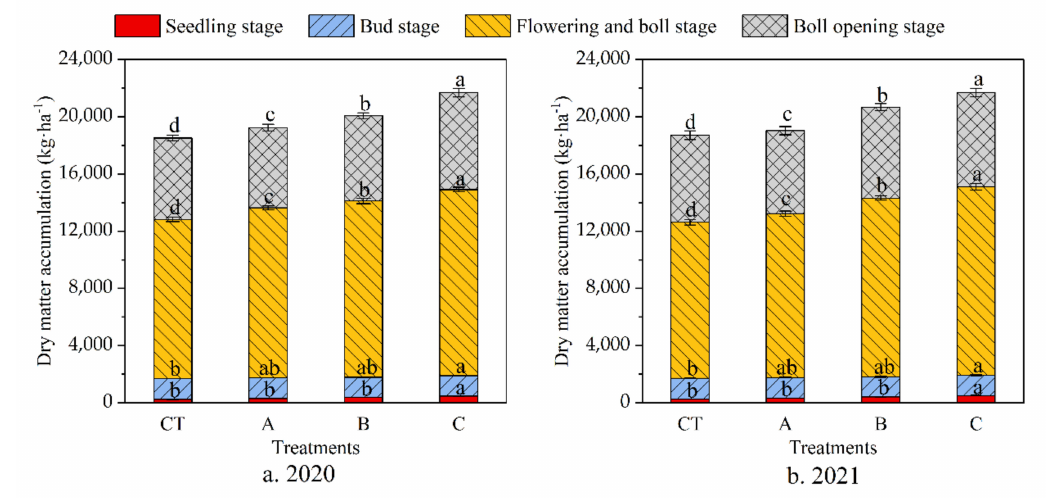
Figure 6. Effects of different smashing ridge tillage depth treatments on dry matter production of cotton in ( a ) 2020 and ( b ) 2021. Different lowercase letters represent significant differences ( p < 0.05, t -test) between treatments per year. CT, conventional tillage; A, 20 cm; B, 40 cm; C, 60